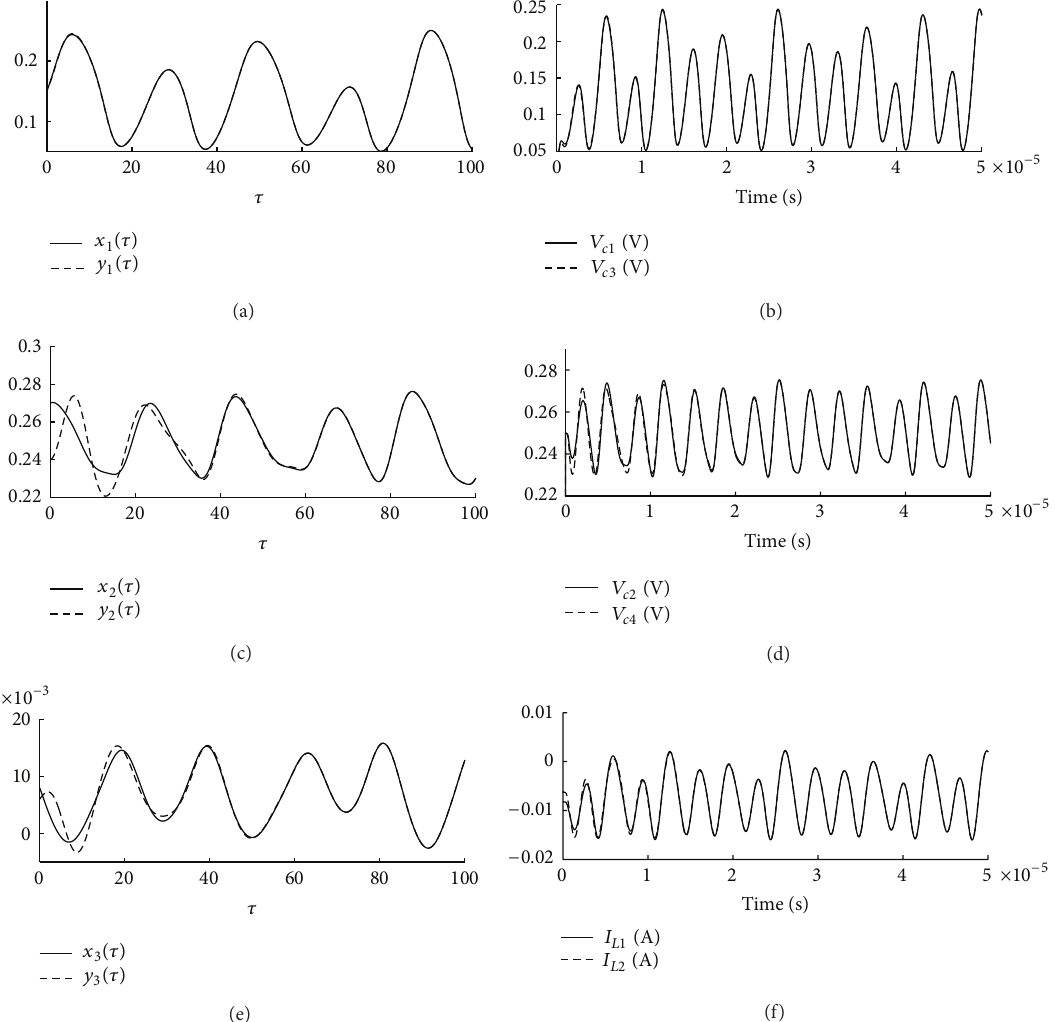
Figure 3: Time evolution of the master system (solid lines) and slave system (dashed lines) from Matlab simulations (left) and Pspice simulations